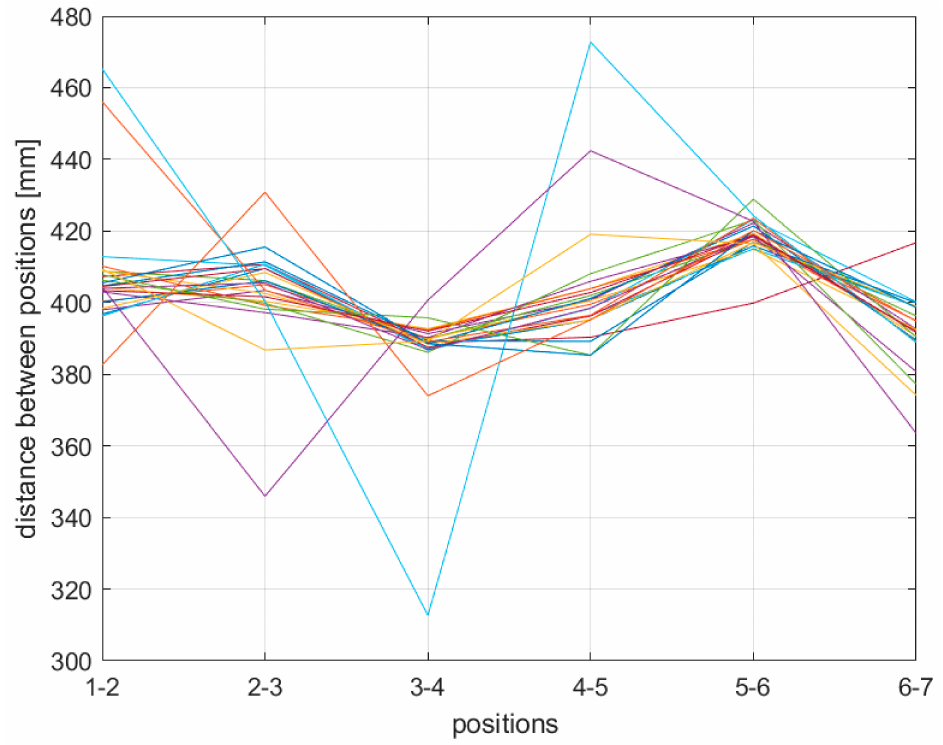
Figure 15. Body joint relative accuracy measurements of Kinect v2.